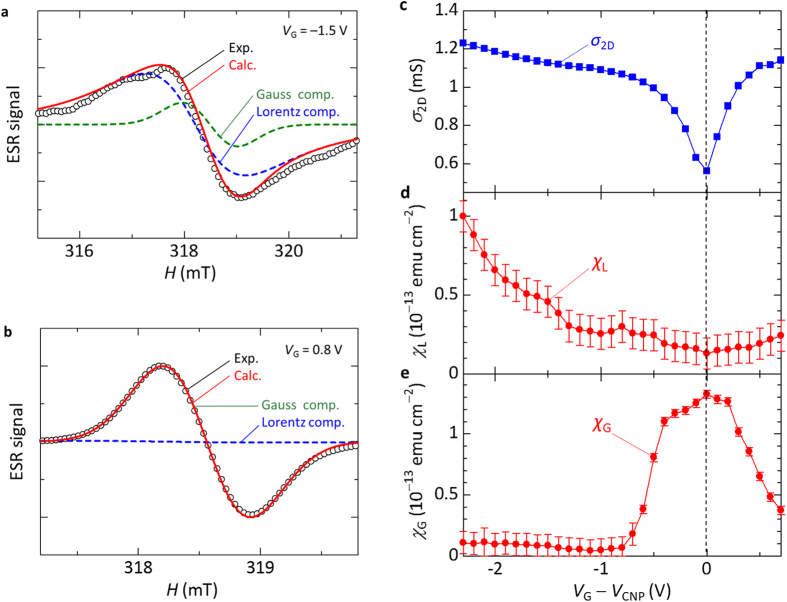
Spin susceptibility due to the charge carries (Lorentzian component) and the atomic vacancies (Gaussian component) of the graphene transistor.(a,b) Fitting analysis for the ESR spectrum of the graphene transistor at VG = −1.5 V (a) and at VG = 0.8 V (b), respectively. Black circles represent the experimental results. Blue and green dashed lines represent the Lorentzian and Gaussian components, respectively, and the red solid line represents the sum of the Lorentzian and Gaussian components. (c–e), Dependence of the σ2D (c), the spin susceptibility due to the charge carries, χL, (Lorentzian component) (d), and the spin susceptibility due to the atomic vacancies, χG, (Gaussian component) (e) of the graphene transistor on VG − VCNP, where VD = 0.1 V at H⊥ at 300 K.